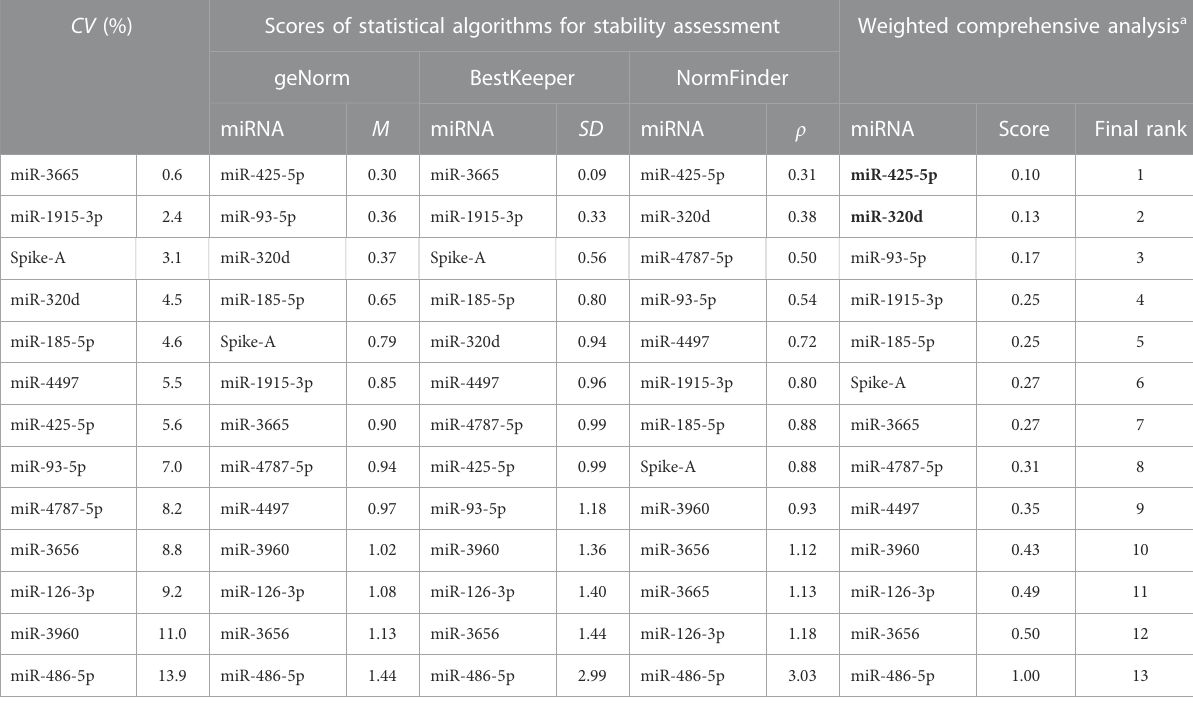
TABLE 3 Abundance stability of candidate miRNA references in plasma of healthy male Caucasians. Scores of statistical algorithms for stability assessment Weighted comprehensive analysis a geNorm BestKeeper NormFinder miRNA Score Final